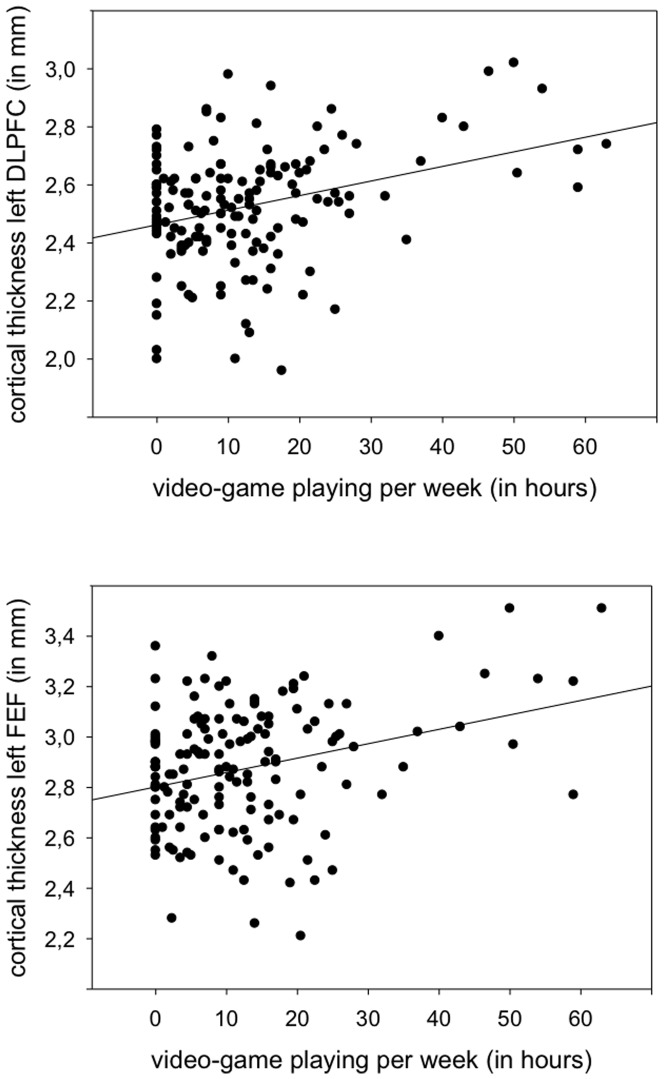
Scatter plot of the association between cortical thickness in left dorsolateral prefrontal cortex (DLPFC, top) and frontal eye fields (FEF, bottom) and hours of video gaming per week.Correlation coefficients are not reported since the brain regions are defined based on a whole brain analysis and applying statistics on these regions could be considered “double dipping” (Kriegeskorte et al., 2009).